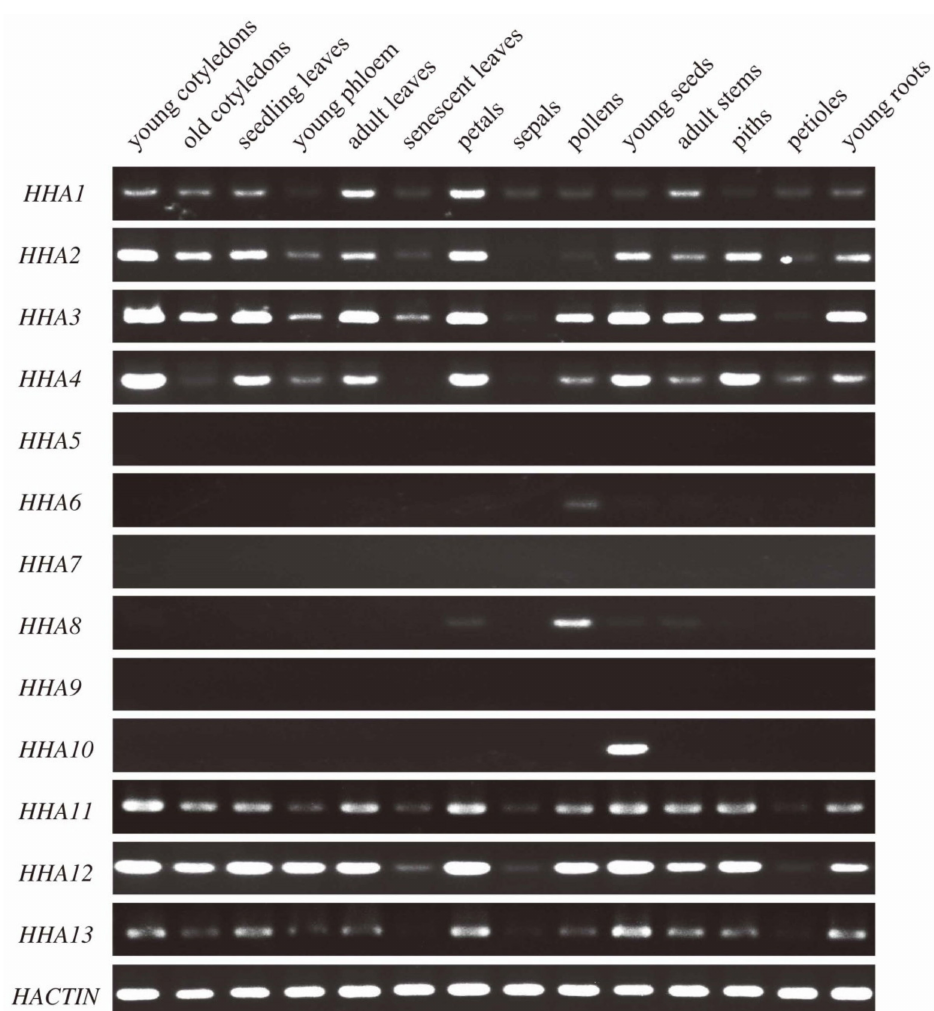
Figure 5. Tissue expression patterns of sunflower HHAs determined by semi-quantitative PCR. All the tissues were collected from the 2-week-old seedlings and 8-week-old adult plants. The HACTIN gene was amplified to normalize the expression level of HHA genes. Semi-quantitative PCR was performed at 28 cycles, and the amplified products were electrophoresed on 2% agarose